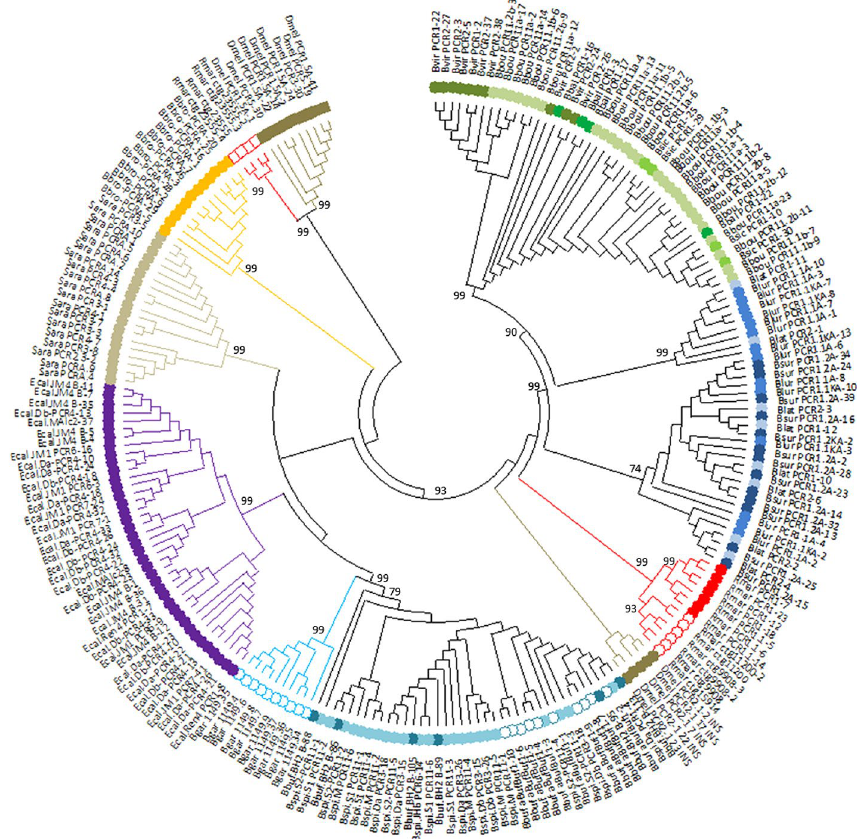
Figure 2. Circular tree for all BamHI-800 sequences using Maximum Likelihood and the Tamura 3-model of sequence evolution 73 . A discrete Gamma distribution was used to model evolutionary rate differences among sites (5 categories (+ G, parameter = 2.7852)). The tree with the highest log likelihood (-22,314.97) is shown. The tree is drawn to scale, with branch lengths measured in the number of substitutions per site. The percentage of trees in which the associated taxa clustered together is shown next to the main branches (values lower than 75% have been omitted). This analysis involved 230 nucleotide sequences and 746 positions in the final dataset (all positions with less than 95% site coverage were eliminated, and ambiguous bases were allowed at any position (partial deletion option)). Species names abbreviations and colour codes at branch leafs as in Fig. 1 and Supplementary Table